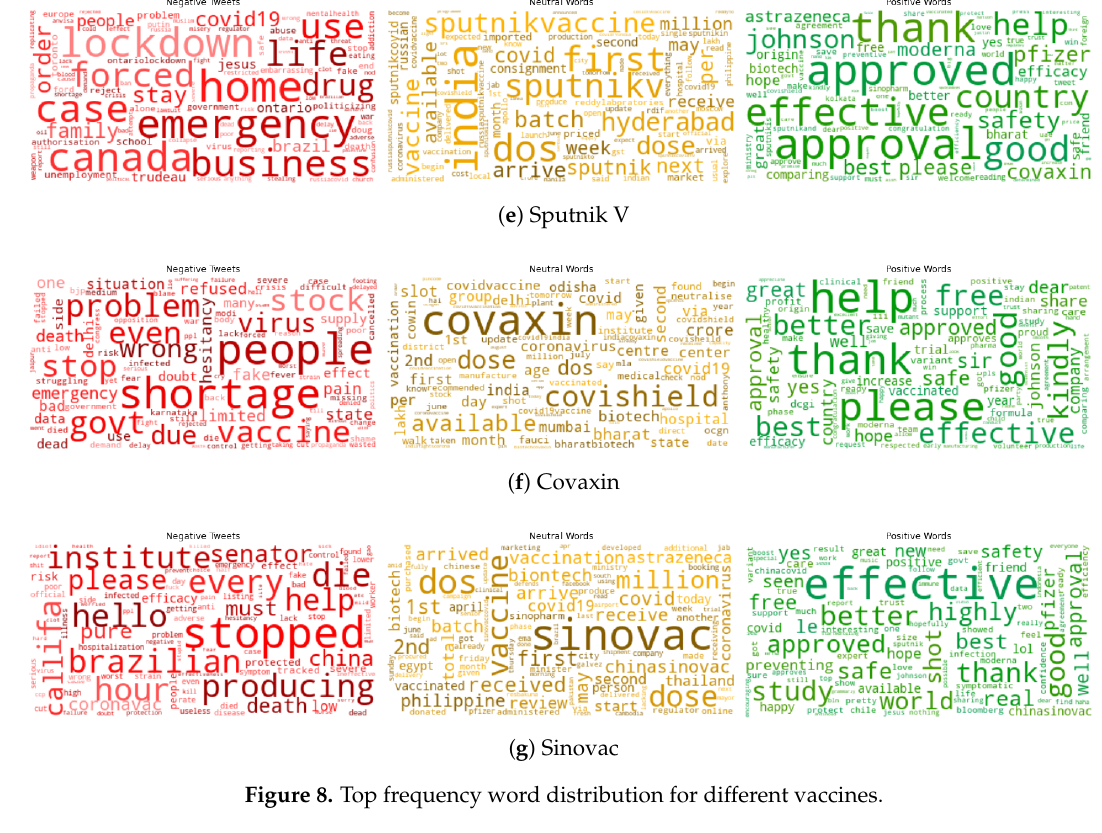
Figure 8. Top frequency word distribution for different